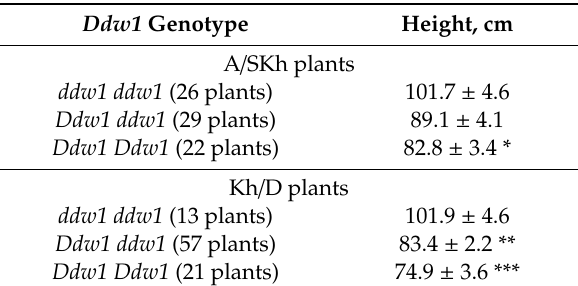
Table 2. The plant height in two plants samples derived from F 2 triticale populations, and its association with Ddw1 genotype. The height is presented as average ± std